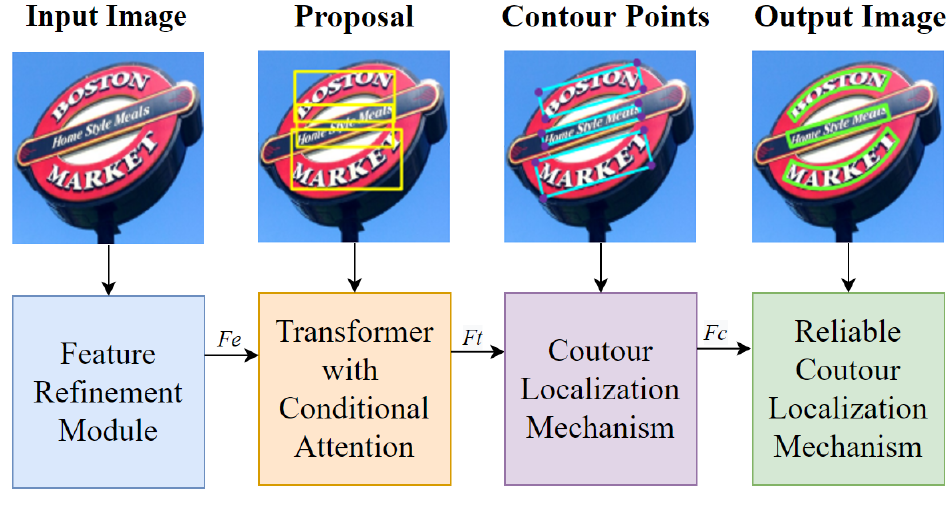
Figure 1. The overall pipeline of the proposed